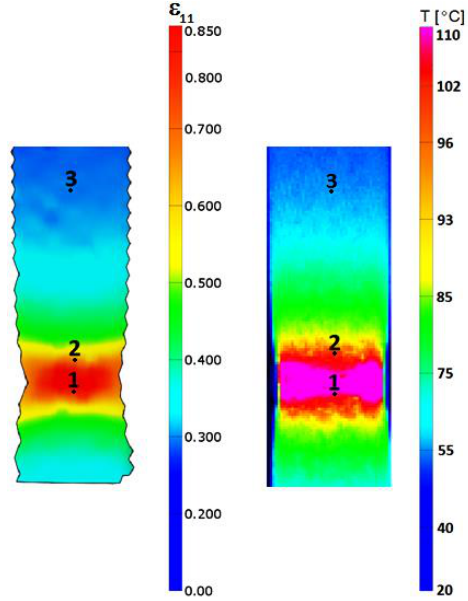
Figure 5. Fields of strain and temperature at the selected time during cyclic loading (five cycles until failure).